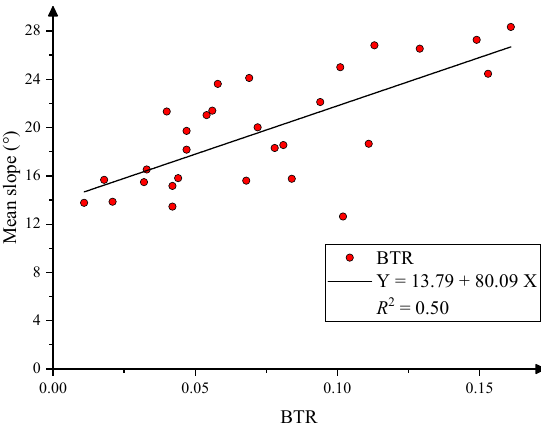
Figure 6. The relationship between the BTR values and mean slope for sub-basins